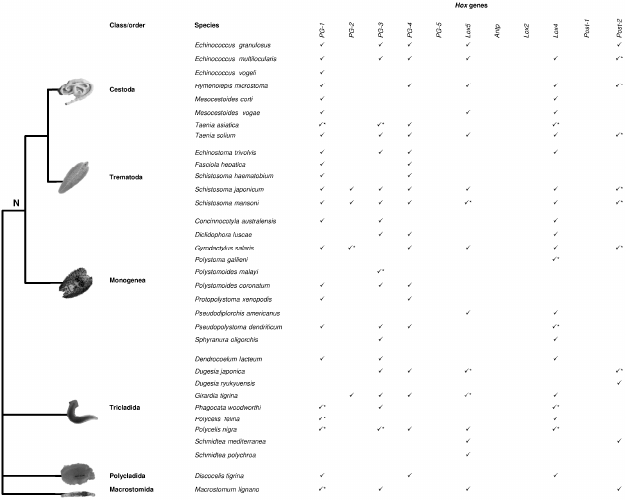
Figure 3. Hox genes in Platyhelminthes. Hox genes identified in the Platyhelminthes phylum are reported. The tree is modified from Hahn et al. [32]. N: Neodermata. * indicates duplicated genes. The duplication reported for PG-2 gene in Gyrodactylus salaris might be due to an erroneous attribution of PG-3 gene. For references see Table S3. The Mollusca phylum is divided into eight classes: Solenogastres, Caudofoveata, and Polyplacophora belonging to Aculifera and Bivalvia, Cephalopoda, Gastropoda, Monoplacophora, and Scaphopoda belonging to the sister taxa Conchifera [92,93]. Mollusks include organisms living in different ecological niches from marine to freshwater and terrestrial environments. Their morphology is extremely variable, ranging from Aplacophora with a wormlike appearance and no shell to Cephalopoda which have a well-developed cephalic region and have co-opted the mantle for locomotion. The muscular foot also presents different morphologies as it is adapted for a variety of functions. With the exception of Monoplacophora, for which no data are available, Hox genes have been identified in a single species of Scaphopoda [40], two species of Aplacophora [40], three species of Polyplacophora [40,57,58], five species of Cephalopoda [26,40,46,55,56], 10 species of Gastropoda [16,20,40,46–54], and 13 species of Bivalvia [24,38–45] (Figure 1, Table S1). Our previous review [94] provided evidence that all 11 genes of the Hox lophotrochozoan cluster are found within Bivalvia, Cephalopoda, and Gastropoda, which are the three most studied molluskan classes. Moreover, genome sequencing has revealed, for the first time in lophotrochozoans, that the gastropod Lottia gigantea presents an intact cluster [20]. In the genome assembly of the Pacific oyster, Crassostrea gigas , the Antp gene is clearly missing and Hox genes are located on four scaffolds [24,38]. In the pearl oyster Pinctada fucata, all 11 Hox genes are present and clustered on three scaffolds. Moreover, non- Hox genes are present in the Hox clusters of both the above-mentioned oysters, thereby suggesting that this is a feature which occurred in their common ancestor [25]. In the genome of the cephalopod, Octopus bimaculoides eight of the 11 Hox genes (with the exception of Hox2 , Hox3 and PG-4 ) have been identified and located on eight separate scaffolds [26].